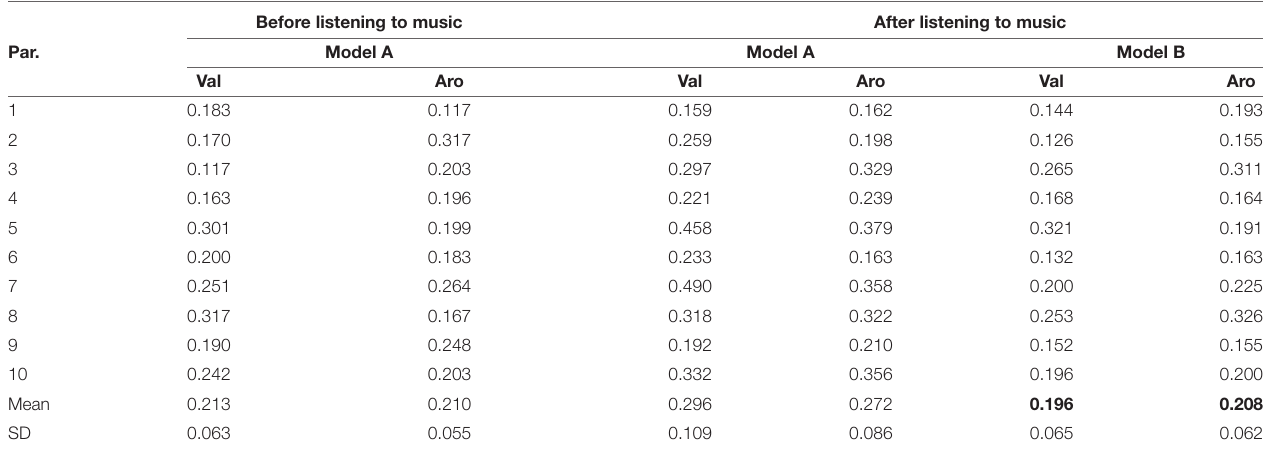
TABLE 4 | RMSE of felt and predicted emotions before or after listening to music in current system: Bold indicates performance of CNN and neural network used by system to generate music. Before listening to music After listening to music